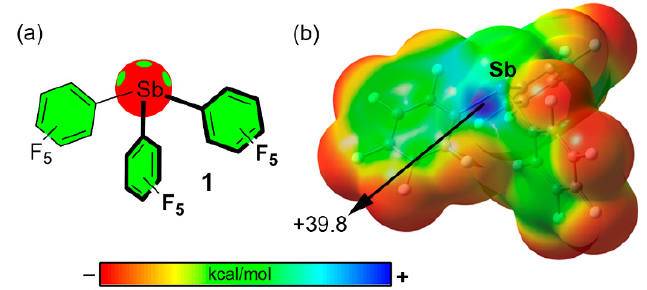
Figure 3. ( a ) Schematic representation and ( b ) MEP surface (0.001 a.u.) of compound 1 (B3LYP/def2- TZVP level of theory) [93]. All MEP surfaces corresponding to Pn and Ch catalysts have been performed using the Gaussian16 calculation package [106].